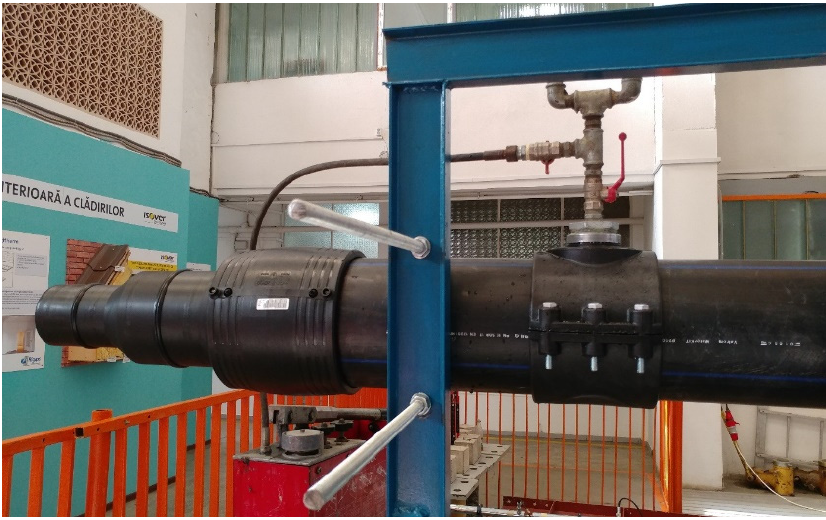
Figure 4. Free end sealing and pressure gauge mounting for internal pressure monitoring.